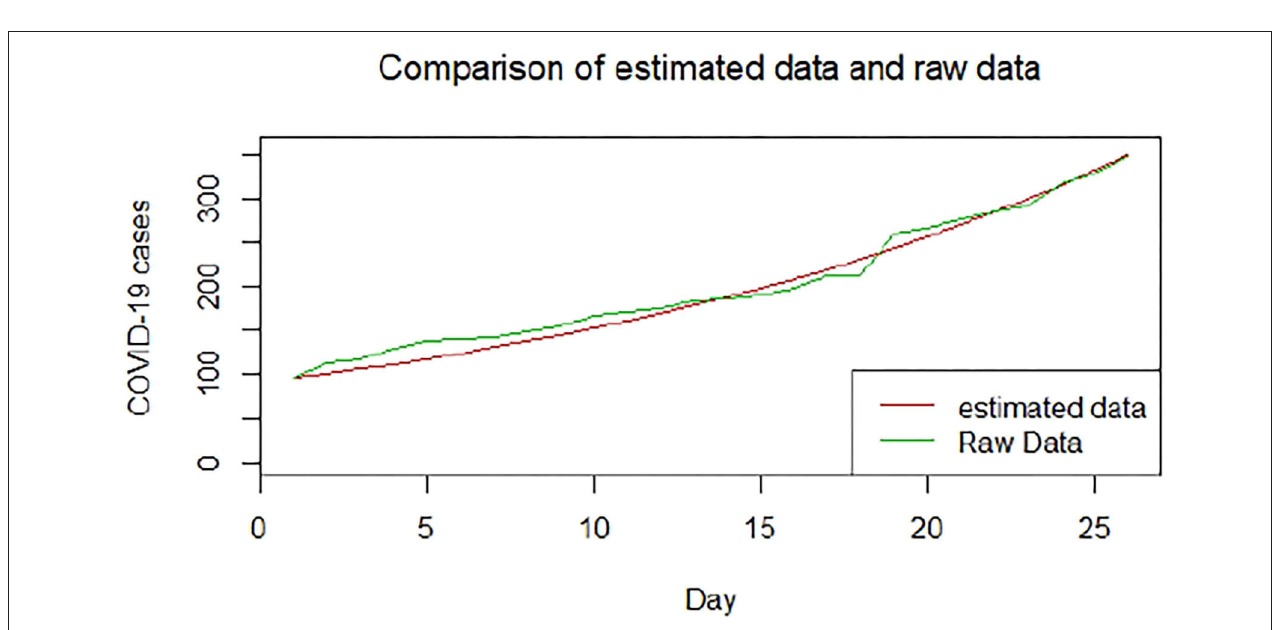
FIGURE 19 | Graph for